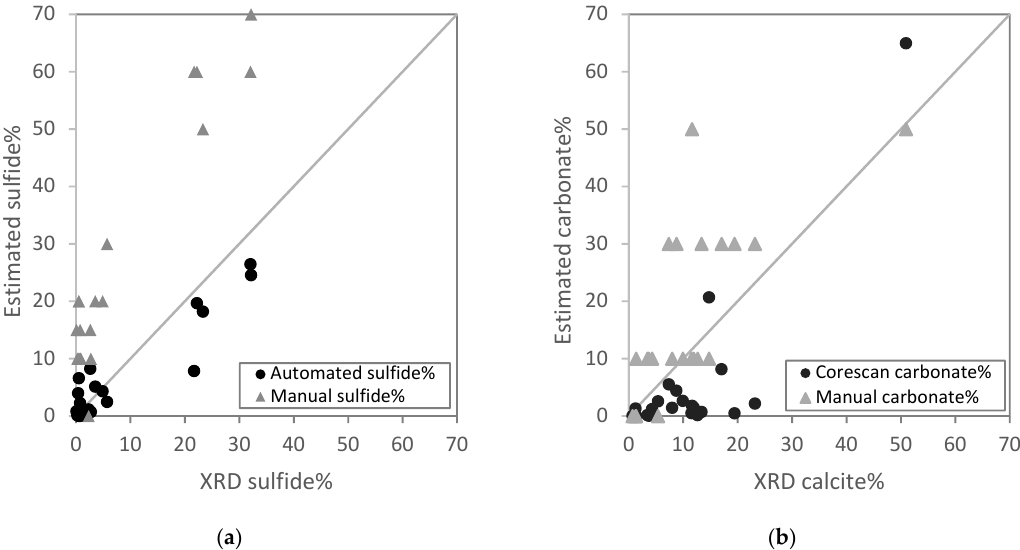
Figure 2. Comparison of XRD derived concentrations and manual and automated estimation of concentration for ( a ) sulfides and ( b ) calcite/carbonate minerals. The solid line indicates a 1:1 relationship.